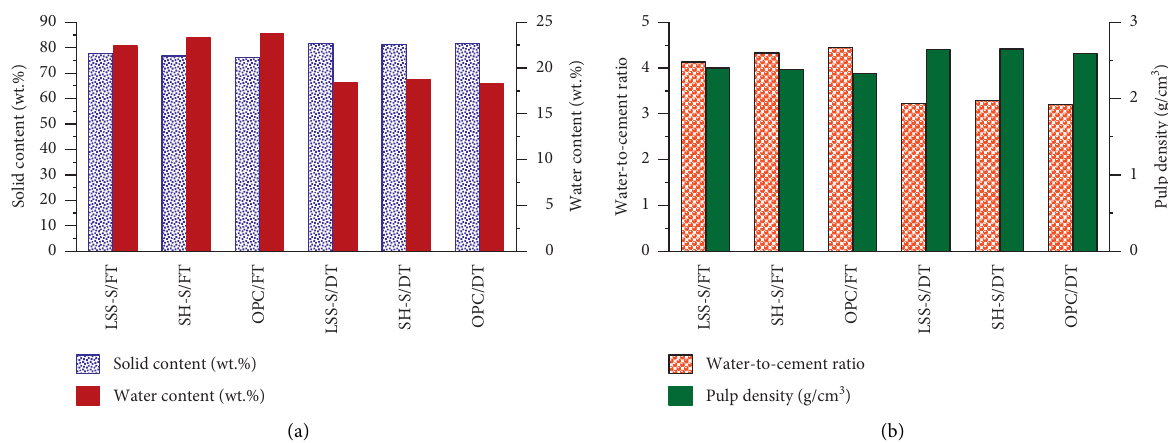
Figure 3: Effect of desliming of the tailings on the properties of fresh CPB mixtures.